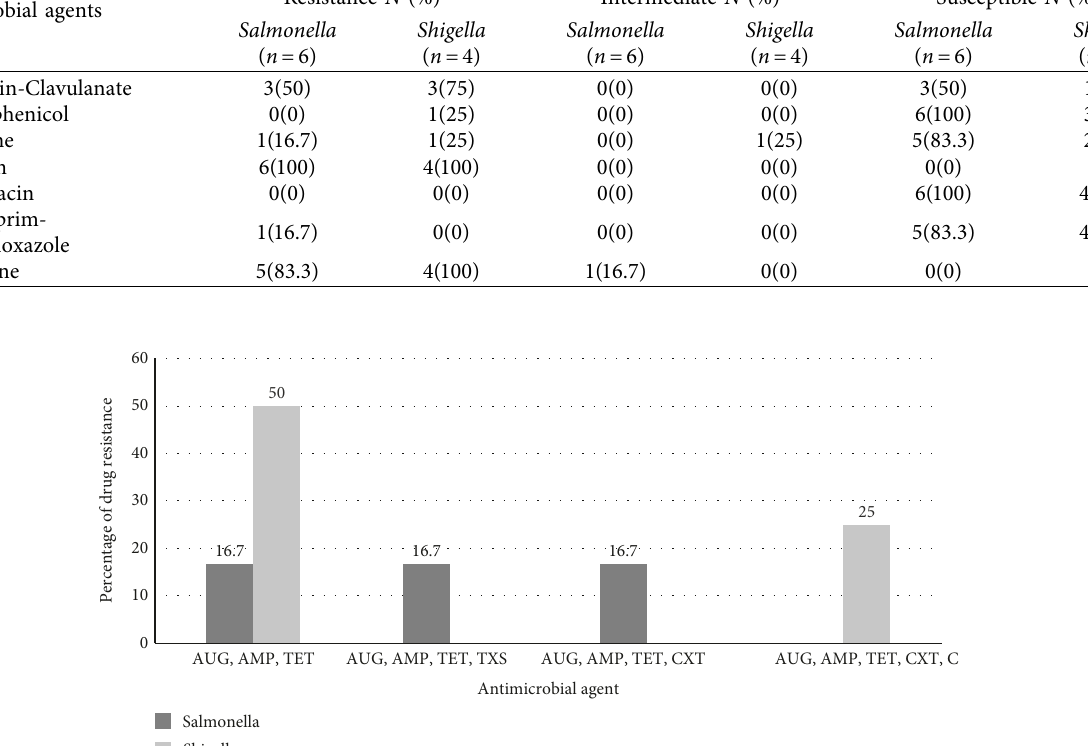
Table 3: Antimicrobial susceptibility patterns of Salmonella and Shigella among food handlers in Motta town, North West Ethiopia. Antimicrobial agents